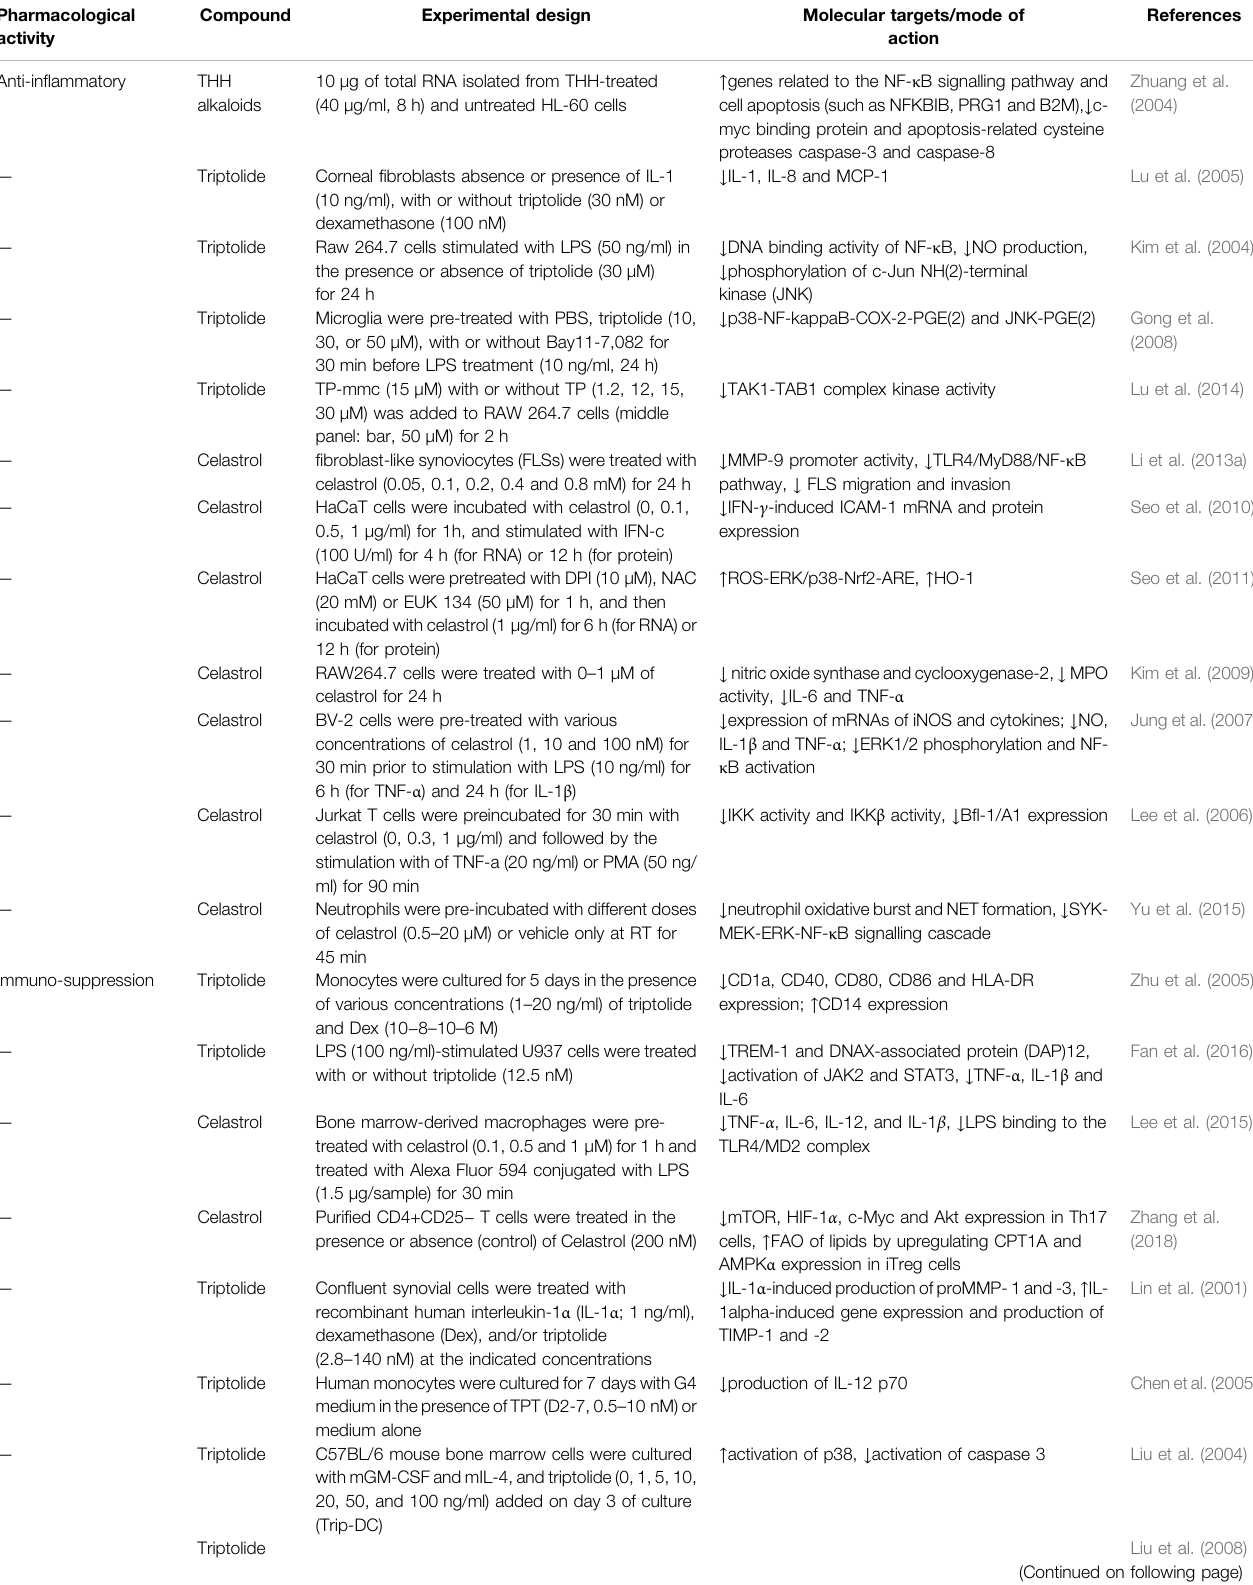
TABLE 4 | Pharmacological effects of different compounds isolated from Tripterygium hypoglaucum in vitro